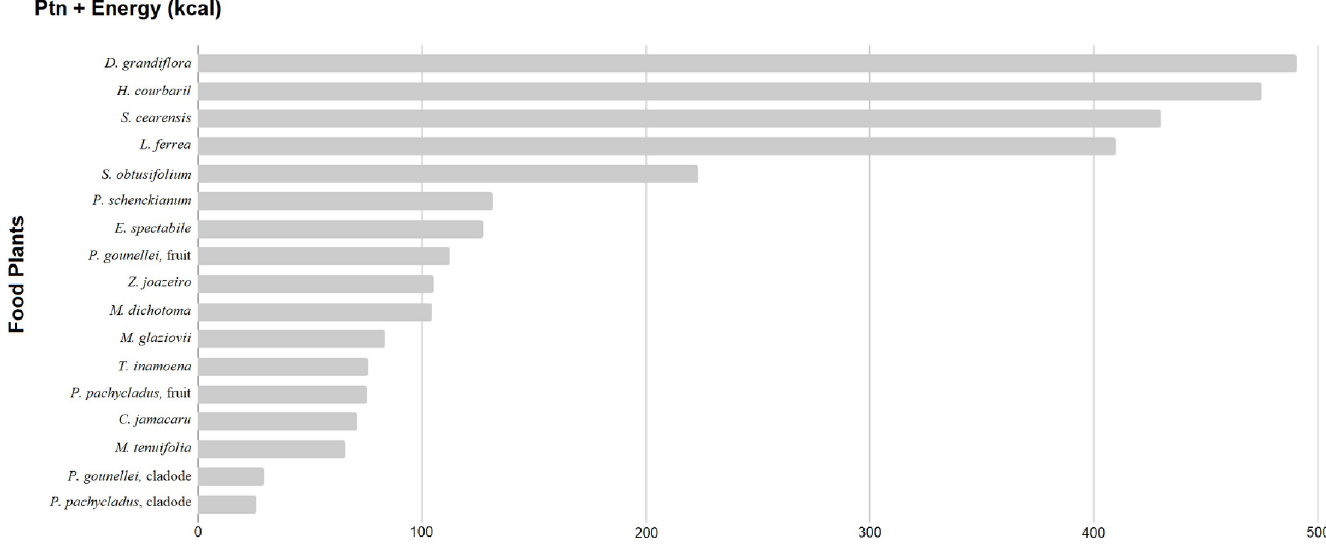
Fig 2. Strategic biodiverse food plants to promote food and nutrition